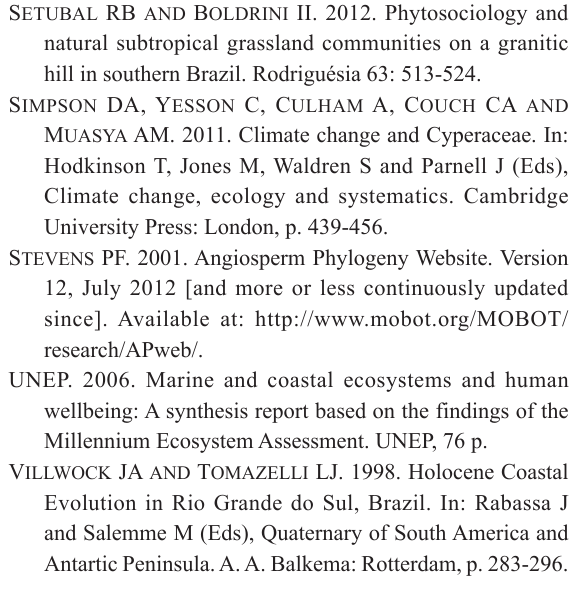
TABLE SI - Species presence in four subregions of South Brazil coastal grasslands, the five most important